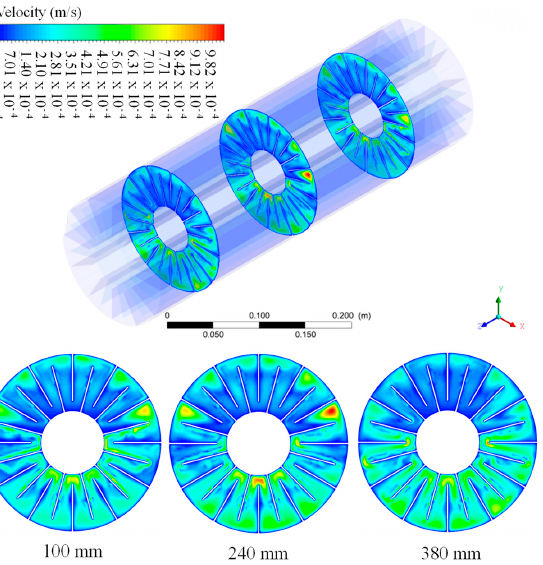
Figure 23. Distribution of velocities in the PCM domain for 80% (t = 5272 s) of its volume in a liquid state.